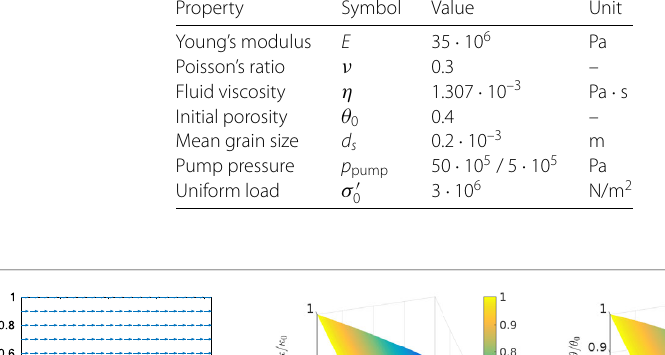
Table 5 An overview of the values of the model parameters Property Symbol